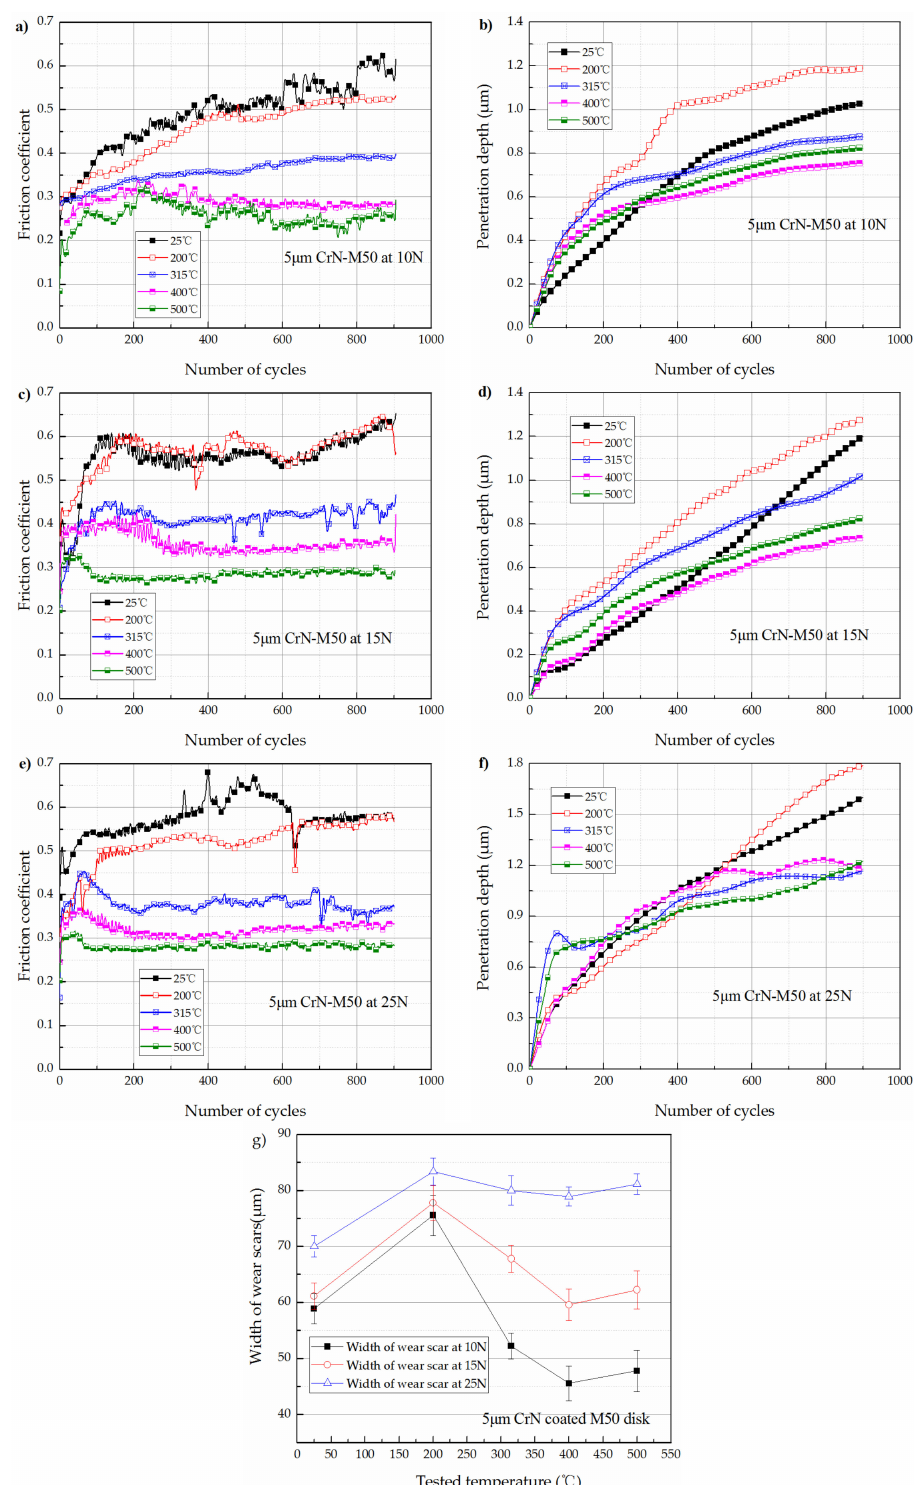
Figure 6. Friction coefficient curves and penetration depth during wear test of the 5 µ m CrN coated M50 disks: ( a ) variation of friction coefficient with temperatures under 10 N; ( b ) variation of penetration depth with temperatures under 10 N; ( c ) variation of friction coefficient with temperatures under 15 N; ( d ) variation of penetration depth with temperatures under 15 N; ( e ) variation of friction coefficient with temperatures under 25 N; ( f ) variation of penetration depth with temperatures under 25 N; and ( g ) variation of width of wear scars with